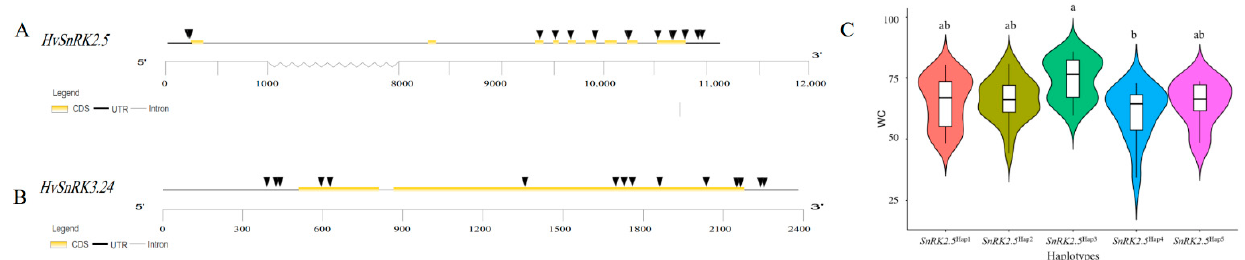
Figure 9. SNPs analysis of HvSnRK2.5 and HvSnRK3.24 in 100 accessions of barley core collections. ( A ) Gene structures and SNPs location of HvSnRK2.5 . ( B ) Gene structures and SNPs location of HvSnRK 3.24. Black triangles indicate the SNP distribution. ( C ) Water content of different haplotypes of HvSnRK2.5 in 100 barley accessions under drought treatment. Capital letters represent significant differences according to Tukey’s honest significant difference (HSD) test ( p < 0.05).